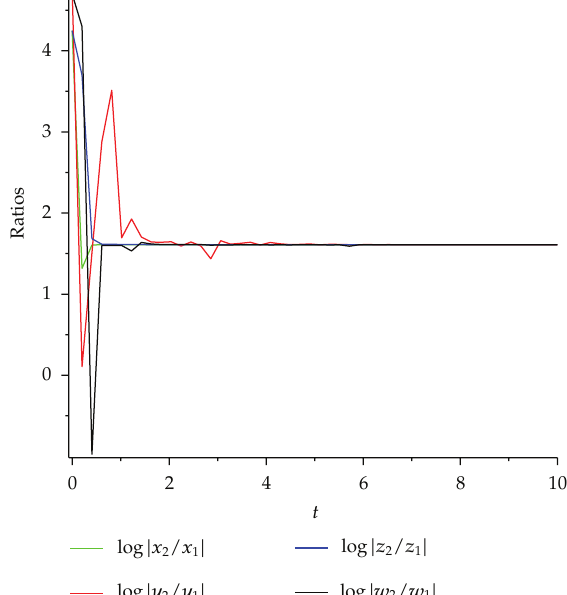
Figure 14: It shows the evaluation of the ratios log | x 2 /x 1 | , log | y 2 /y 1 | , log | z 2 /z 1 | , and log | w 2 /w 1 | whose limits are equal to log5 (cid:8) 1 .